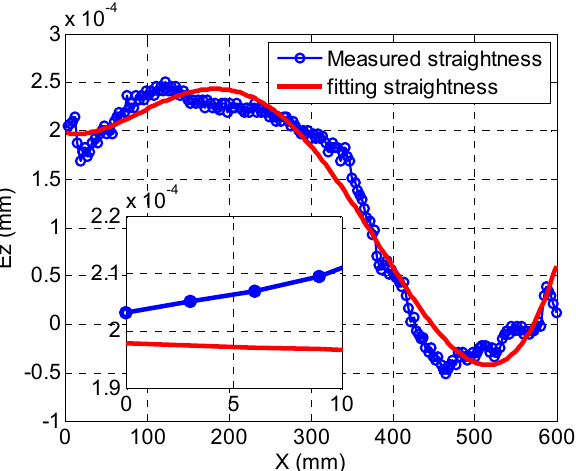
Figure 4. Measurement and fitting curve of